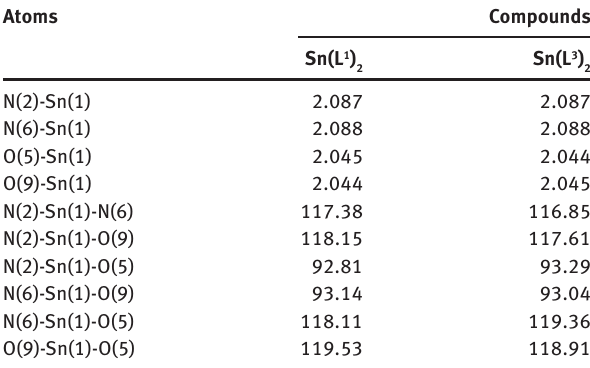
Table 5: Selected lengths (Å) and bond angles of ( ° ) of complex Sn(L 1 ) and Sn(L 3 ) . 2 2